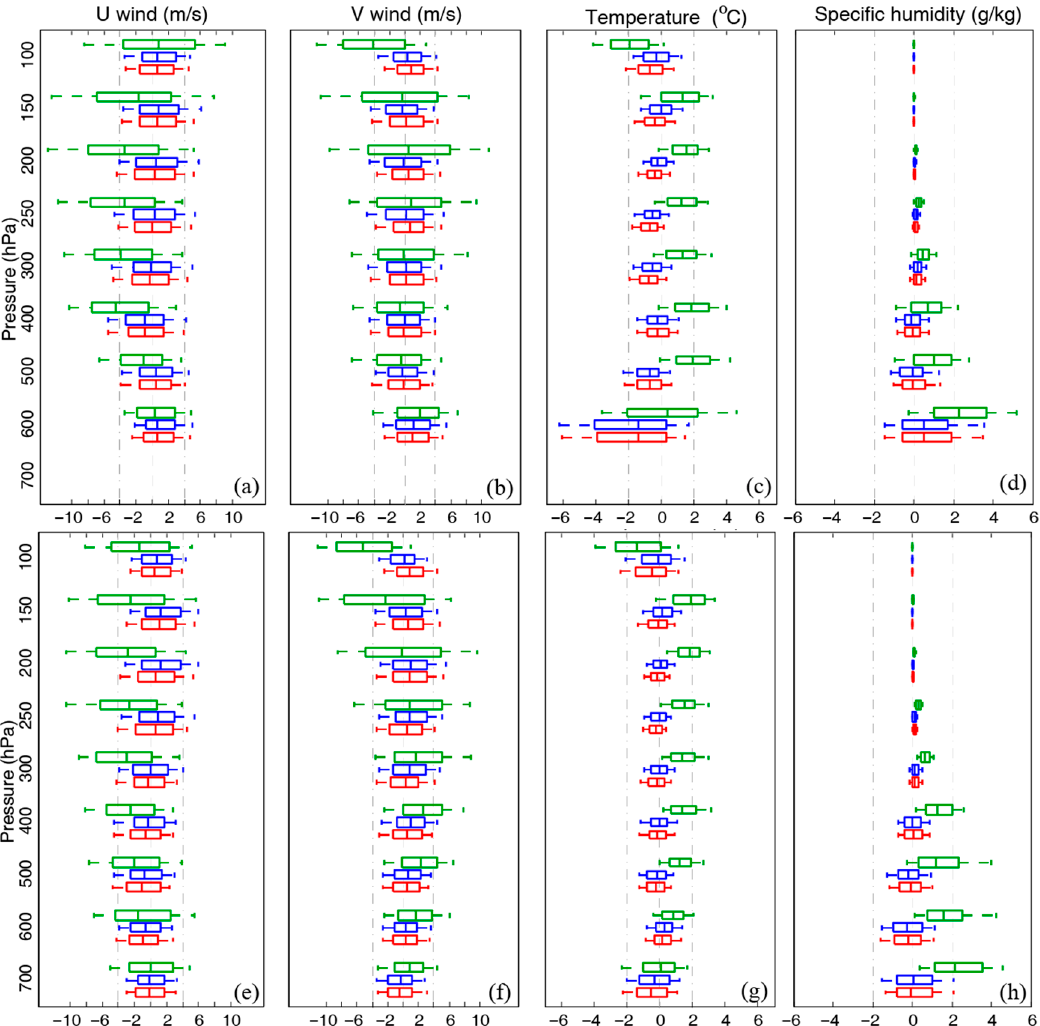
Figure 5. Box-and-whisker plots of U, V, T, and Q bias for all independent soundings over TP ( a – d ) and YGP ( e – h ) for 20thCR (green), JRA-55C (blue), and JRA-55 (red), verified against observations (reanalysis-minus-observation (R-O)) during the 2008 JICA/Tibet Project IOP. The central mark is the median, the edges of the box are the 25th and 75th percentiles, and the whiskers extend to the 10th and 90th percentiles.